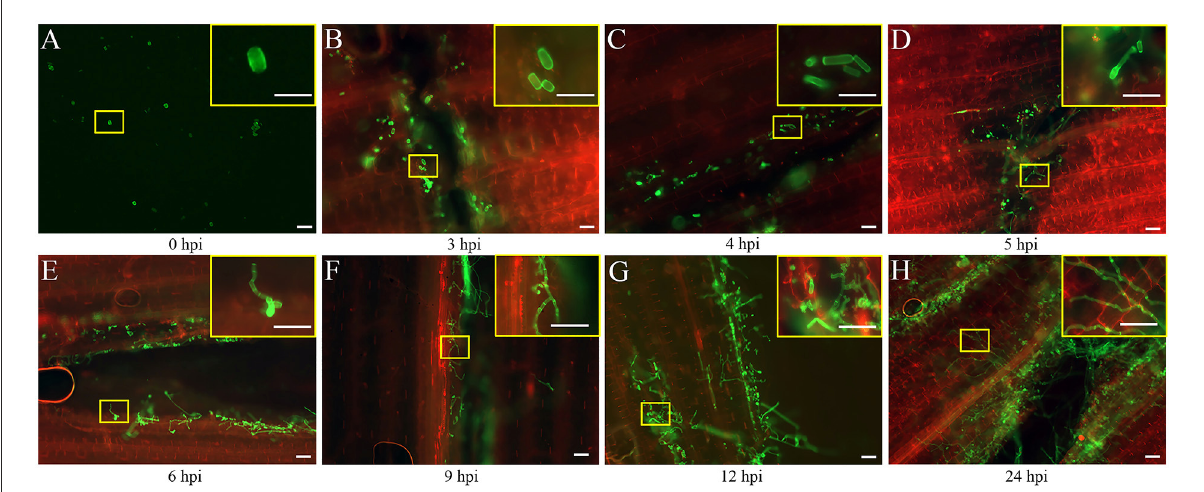
FIGURE1 Early developmental characteristics of biotrophic Ustilago maydis in maize. (A–H) Maize leaves were collected at 0, 3, 4, 5, 6, 9, 12, and 24 hpi respectively with U. maydis FB1 × FB2 strain. The image with the yellow border in the upper right-hand corner represents a magnified view of the position of the yellow box. The development of the fungal hyphae was visualized via WGA-AF488 (green) staining. The plant cell wall was stained with propidium iodide (red) and observed using a confocal microscope. Scale bar = 50 µ m.